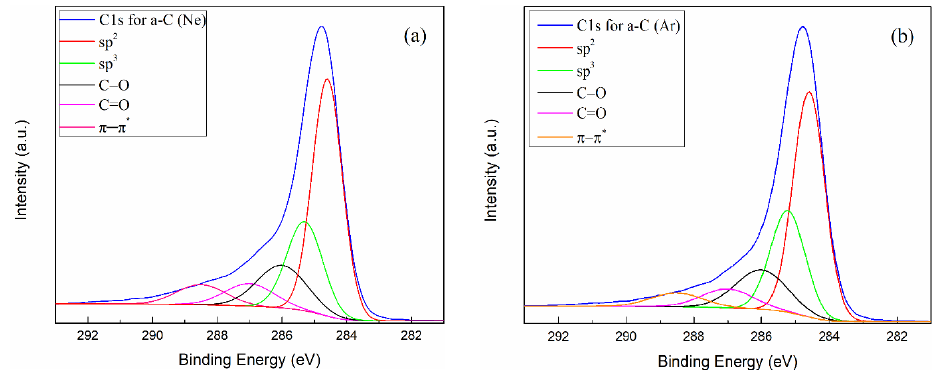
Figure 5. X-ray photoelectron spectroscopy C1s spectra of a-C coatings deposited with ( a ) Ne and ( b ) Ar, fitted by five Gaussian functions.